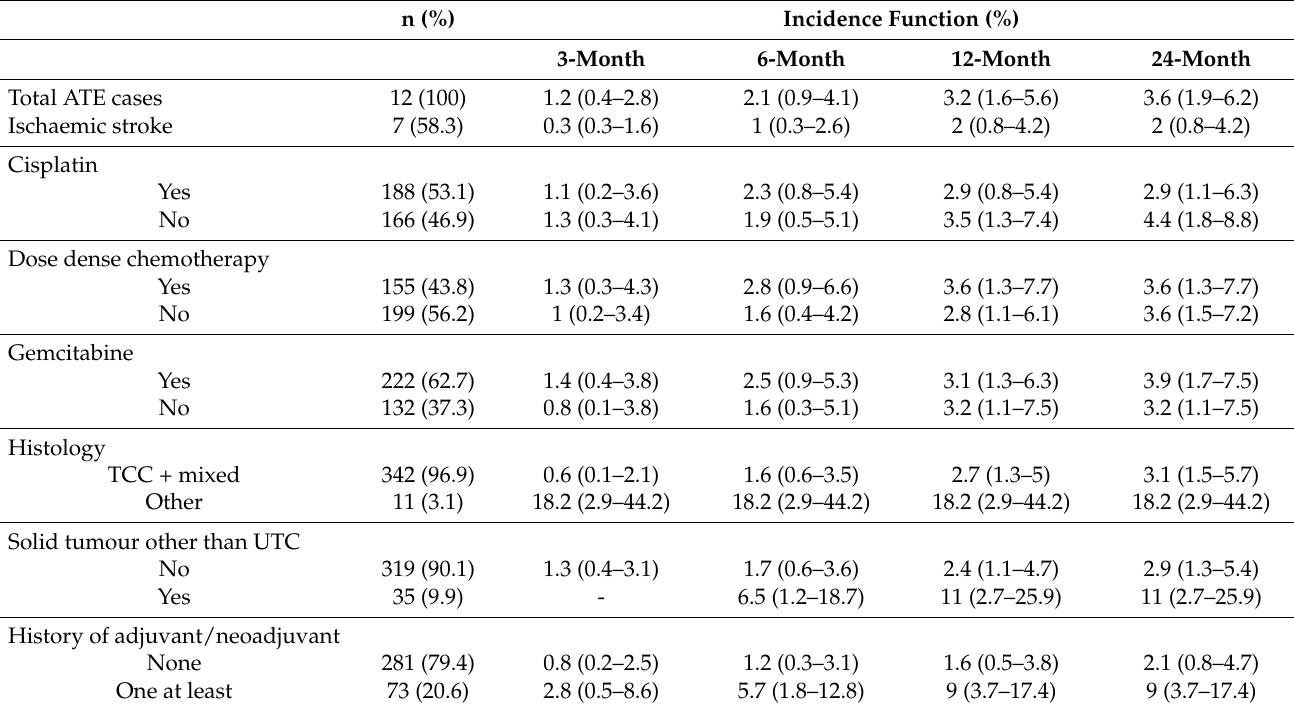
Table 2. Arterial thromboembolic (ATE) risk in 354 patients with advanced urinary tract cancer receiving first-line chemotherapy. Incidence function was calculated with death as a competing risk. The 95% confidence intervals are shown in